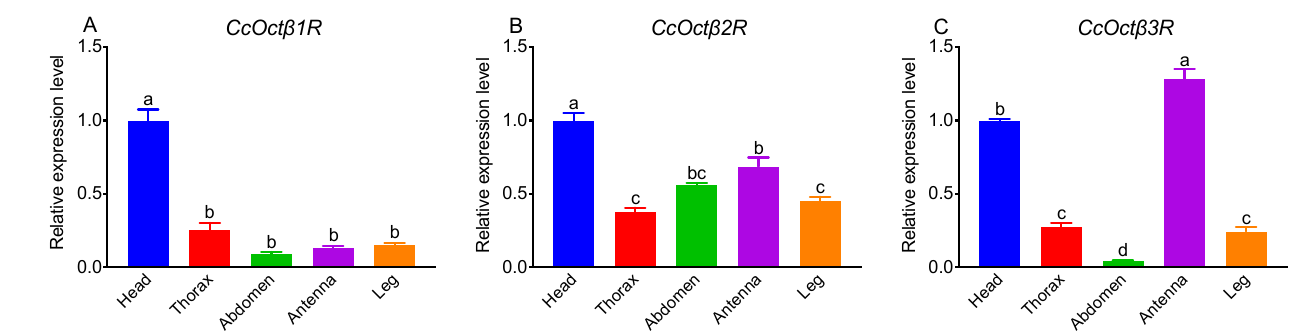
Figure 2. Relative transcript levels of CcOct β 1R ( A ), CcOct β 2R ( B ), and CcOct β 3R ( C ) in different tissues of Cotesia chilonis adults. Different lowercase letters on the bars represent statistical differences in the transcript levels ( p < 0.05, Tukey’s HSD test). Data are expressed as the means ± SE of three biological replicates.